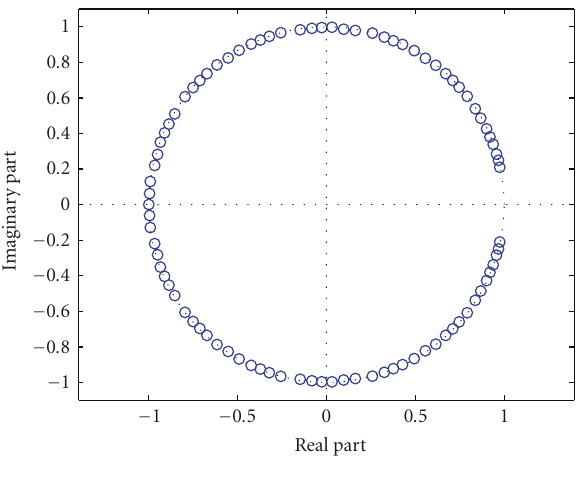
Figure 3: Zero plot of H ( z ).